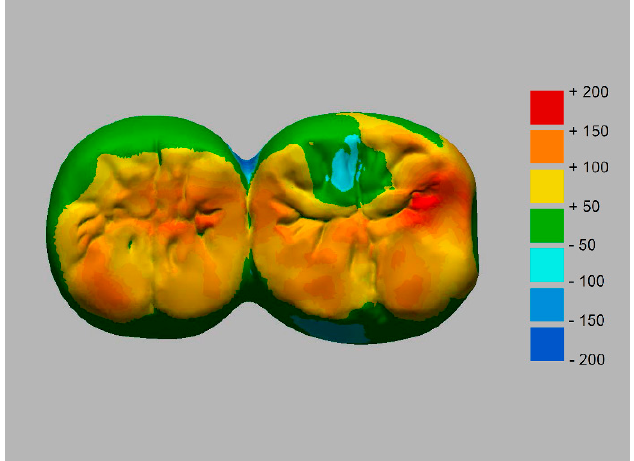
Figure 4. Superimposed occlusal image between the original and modified designs of the prosthesis.